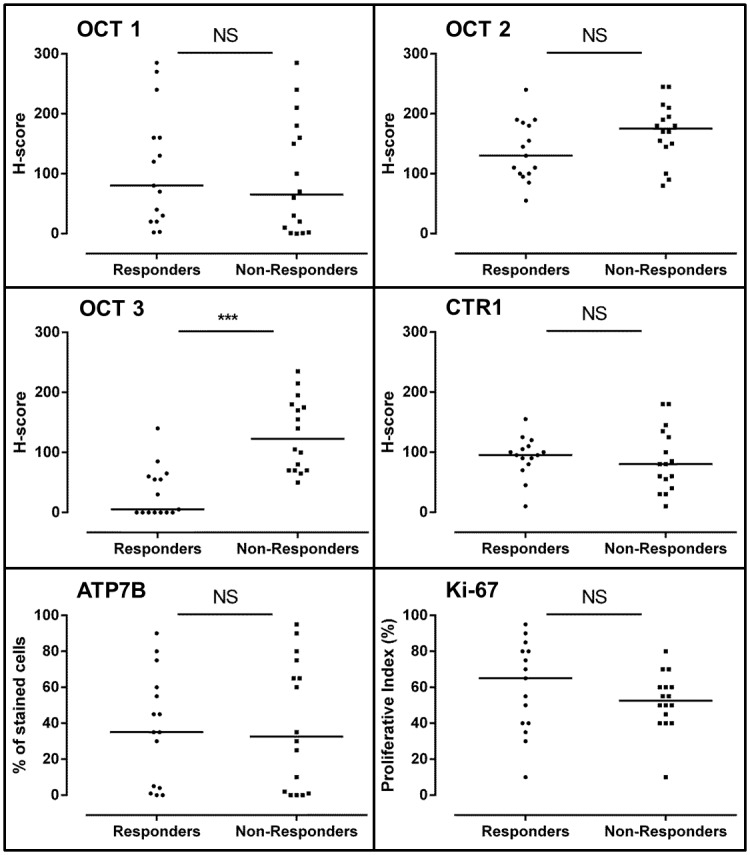
Distribution and median of H-scores for OCT1, 2, 3, CTR1, ATP7B and Ki-67 for responder and non-responder patients.(NS: not significant, p>0.05; ***: p<0.001).